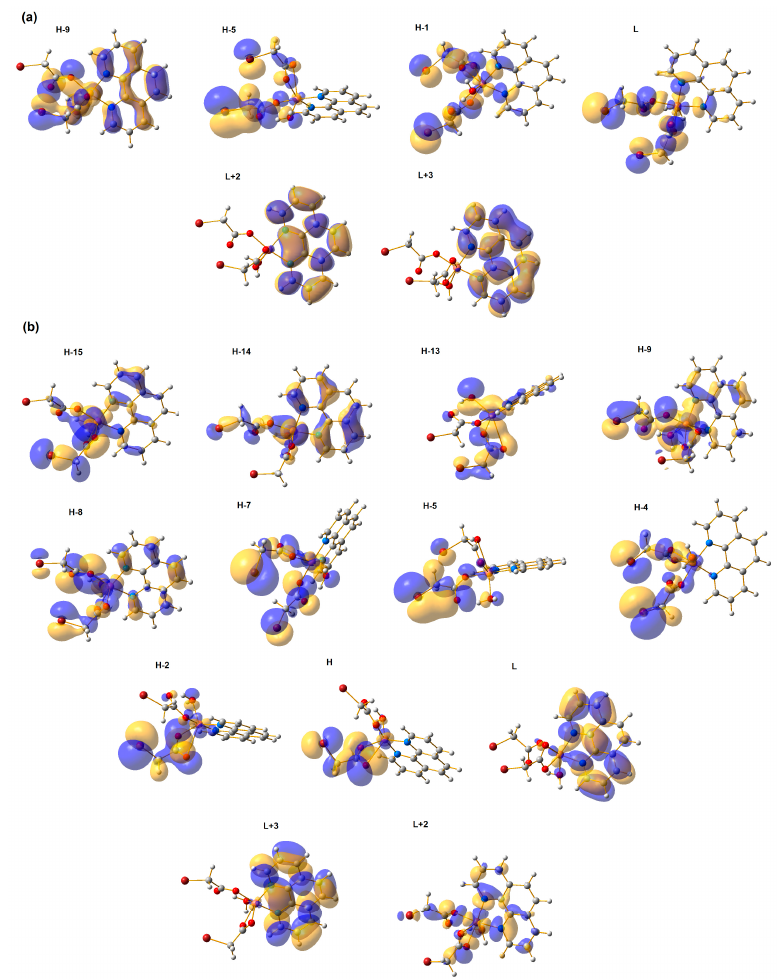
Figure 4. Calculated molecular orbitals of compound 1 : α ( a ) and ß ( b ). H letter indicates HOMO, L-LUMO, and ± (number) represents subsequent orbitals above HOMO and LUMO,